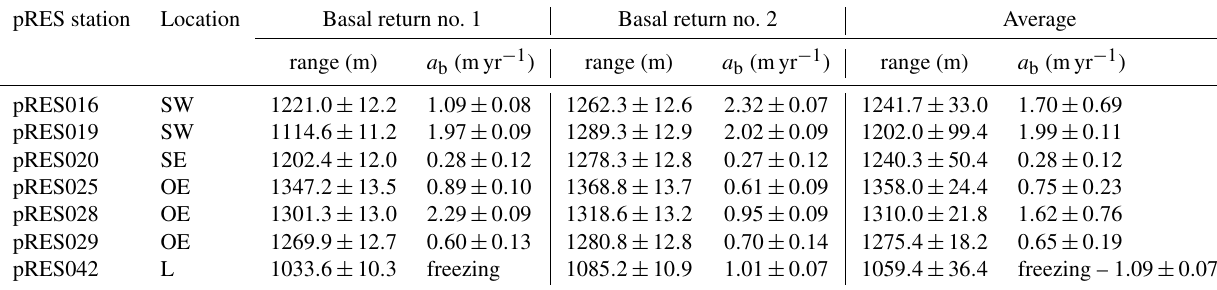
Table A1. Melt rates determined from different basal returns.